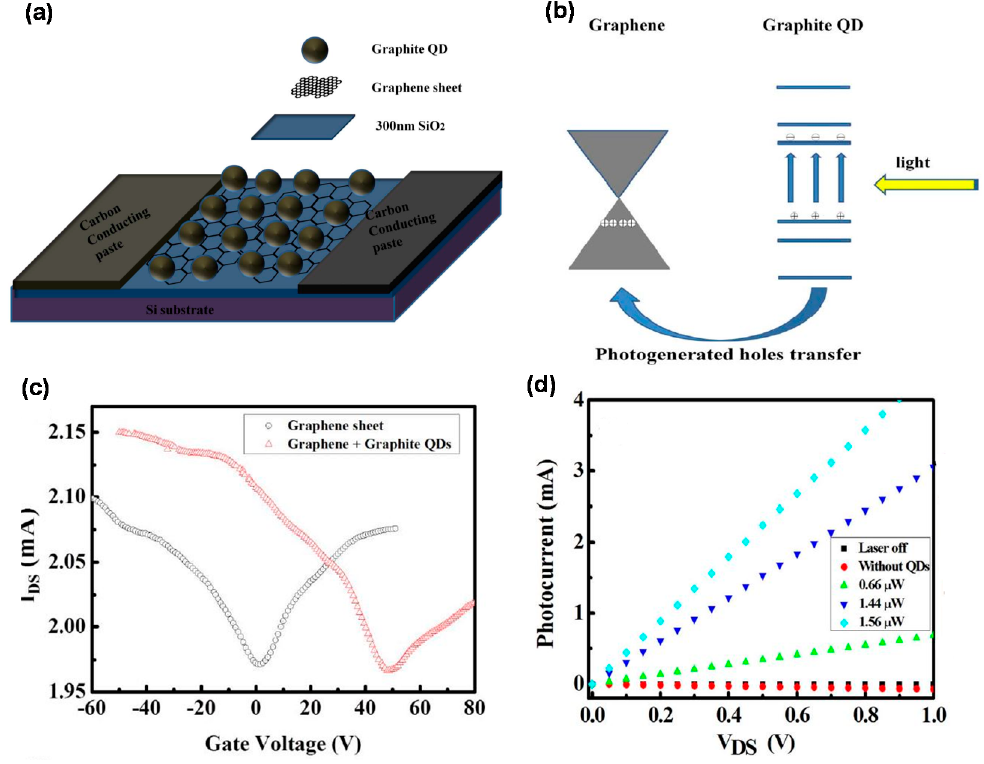
Figure 10. ( a ) Schematic of all carbon-based PD; ( b ) Under light illumination, the hole can transfer from graphite quantum dots to graphene sheets. The photo-generated electrons are trapped in graphite quantum dots; ( c ) Transfer characteristics of graphene transistors with and without the addition of graphite QDs on the graphene sheet; ( d ) Photocurrent of all carbon-based photodetectors for different optical powers as functions of drain-source voltage ( V DS ), showing a linear dependence on bias. The PC for the pure graphene device without graphite quantum dots is also shown here, which indicates a negligible effect. Reproduced with permission for Figure 10a–d from 2013 Scientific Reports